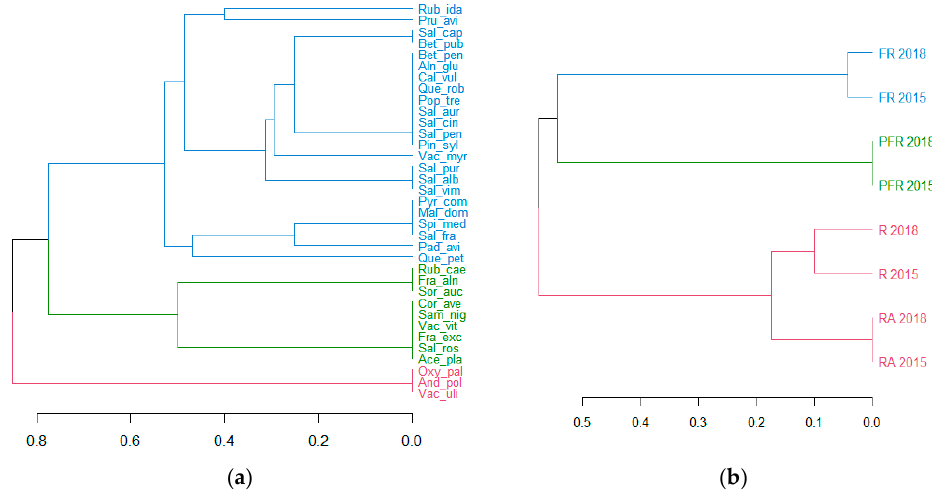
Figure 3. A dendrogram of hierarchical classification for tree and shrub species ( a ) and their similarity for shore sectors of the lake in 2015 and 2018 ( b ) based on Jaccard’s coefficient and the average linkage method. Species composition of tree and shrub vegetation: Acer platanoides , Alnus glutinosa , Andromeda polifolia , Betula pendula , Betula pubescens , Calluna vulgaris , Corylus avellana , Frangula alnus , Fraxinus excelsior , Malus domestica , Oxycoccus palustris , Padus avium , Pinus sylvestris , Populus tremula , Prunus avium ,